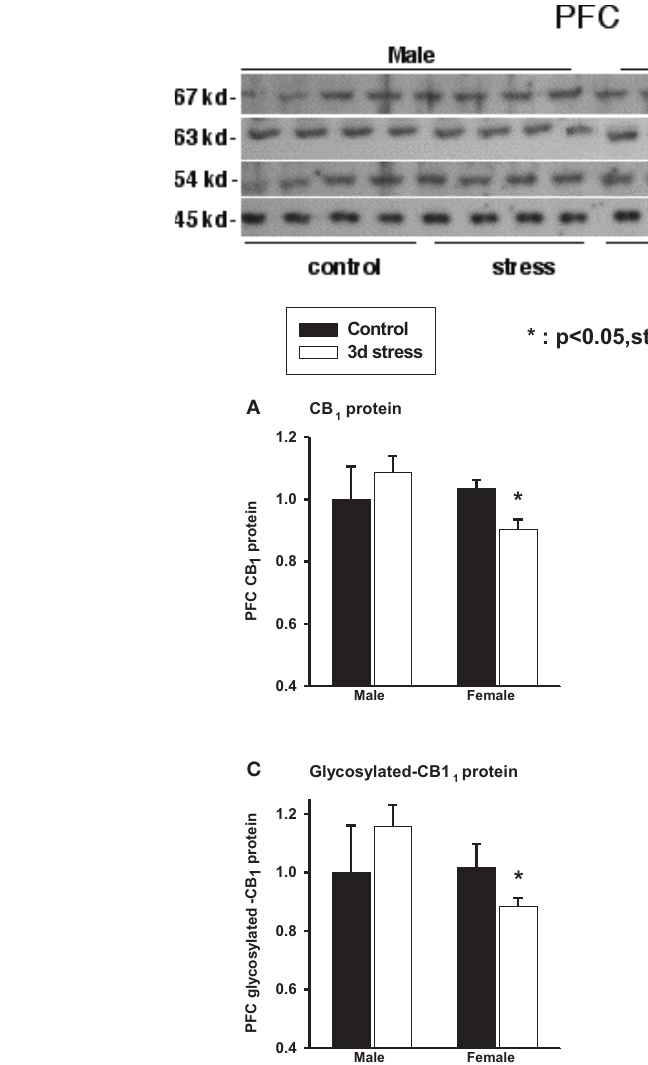
FIGURE 3 | Upper panel: representative western blots of total CB 1 and CB 2 receptor proteins; glycosylated ( g -CB 1 ) and phosphorylated ( p -CB 1 ) CB 1 proteins in rat prefrontal cortex tissue homogenates . Lower panel: two-way ANOVA of the western blot showing a trend level of stress × sex interaction in total CB 1 proteins (A) ; phosphorylated CB 1 proteins ( p -CB 1 ) (B) and; glycosylated-CB 1 proteins (C) . A within-sex one-way ANOVA showed